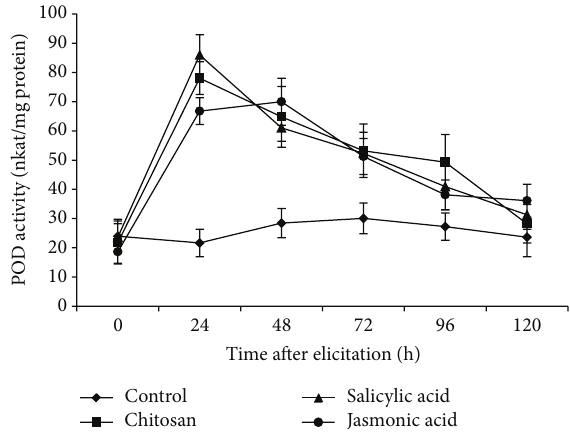
Figure 4: Peroxidase (POD) activity (nkat/mg protein) on a time course after elicitation of the roots of tomato with different elicitors. Values are mean ± SD of triplicate analysis.